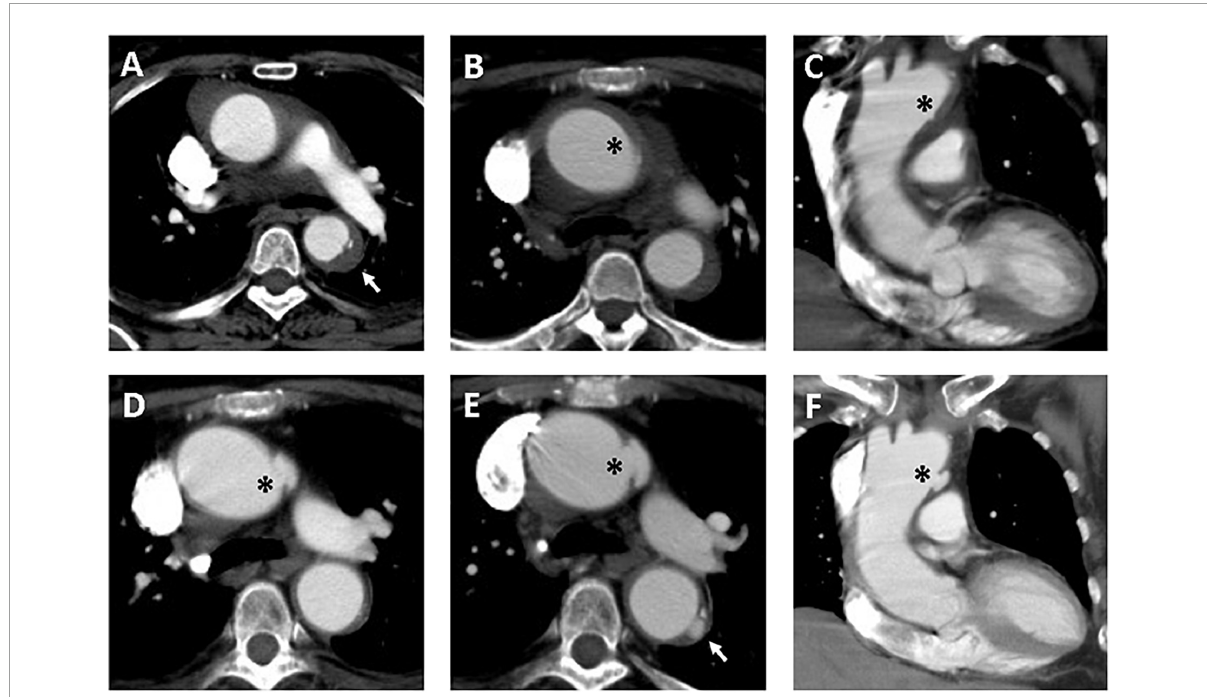
FIGURE3 Serial CT scans showed progression of PAU and ULP in a 69-year-old woman with TAIMH. Contrast-enhanced CT scan showed TAIMH with PAU (arrow) in the proximal descending aorta (A) and ULP (asterisk) in the proximal aortic arch (B,C) . Three months later, the follow-up CT scan showed enlarged ULP ( D , asterisk). The PAU (arrow) in the proximal descending aorta and ULP (asterisk) in the proximal aortic arch were slowly progressed in overall size on 14-month follow-up CT scan (E,F) . The patient received medical treatment alone and was still alive.